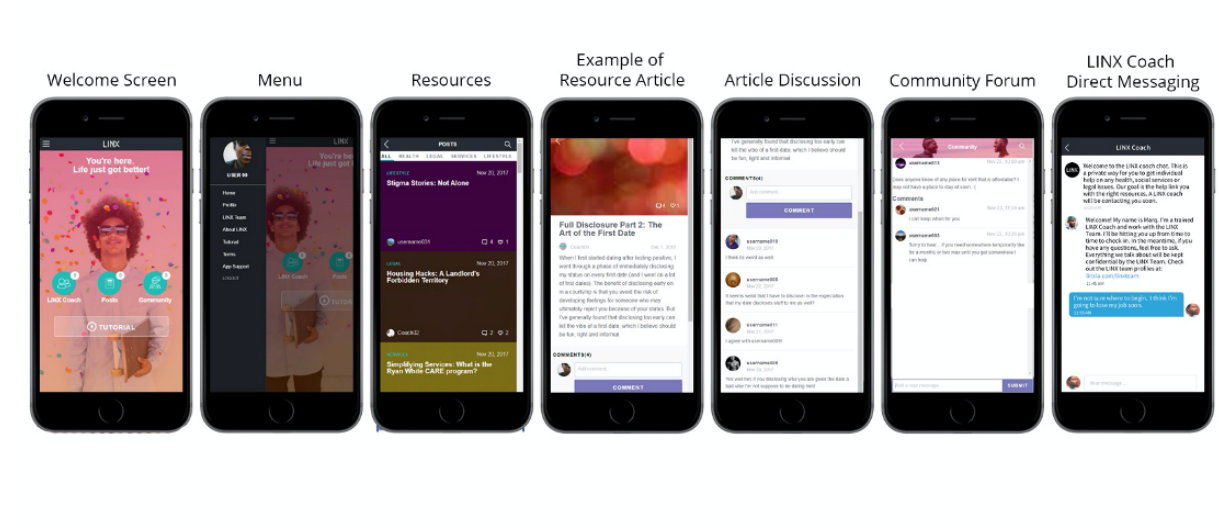
Figure 2. LINX App user